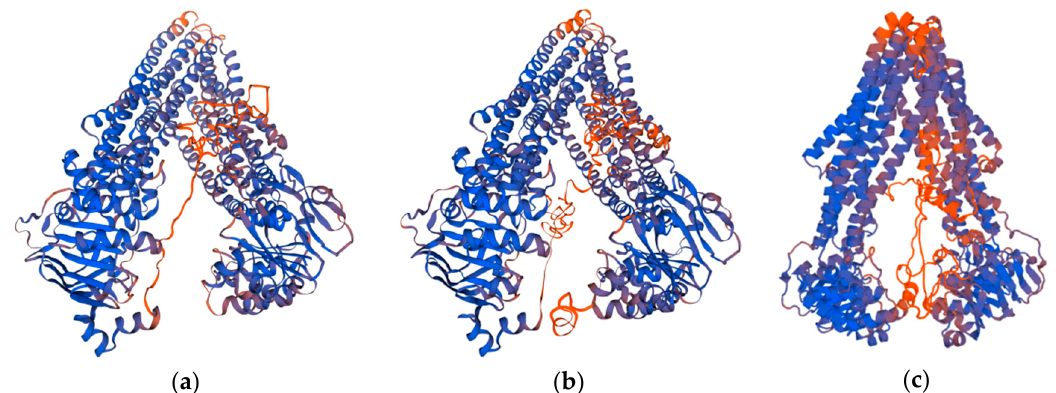
Figure 1. Three-dimensional (3D) structures of the h P-gp models selected. The models are presented in colors based on the QMEAN model quality values to allow instant visualisation of regions of the model that are well (blue) or poorly (orange) modeled: ( a ) Model generated by SWISS-MODEL tool; ( b ) model generated by I-TASSER tool; ( c ) model generated by Discovery Studio 4.1 Client / Modeler 9.12